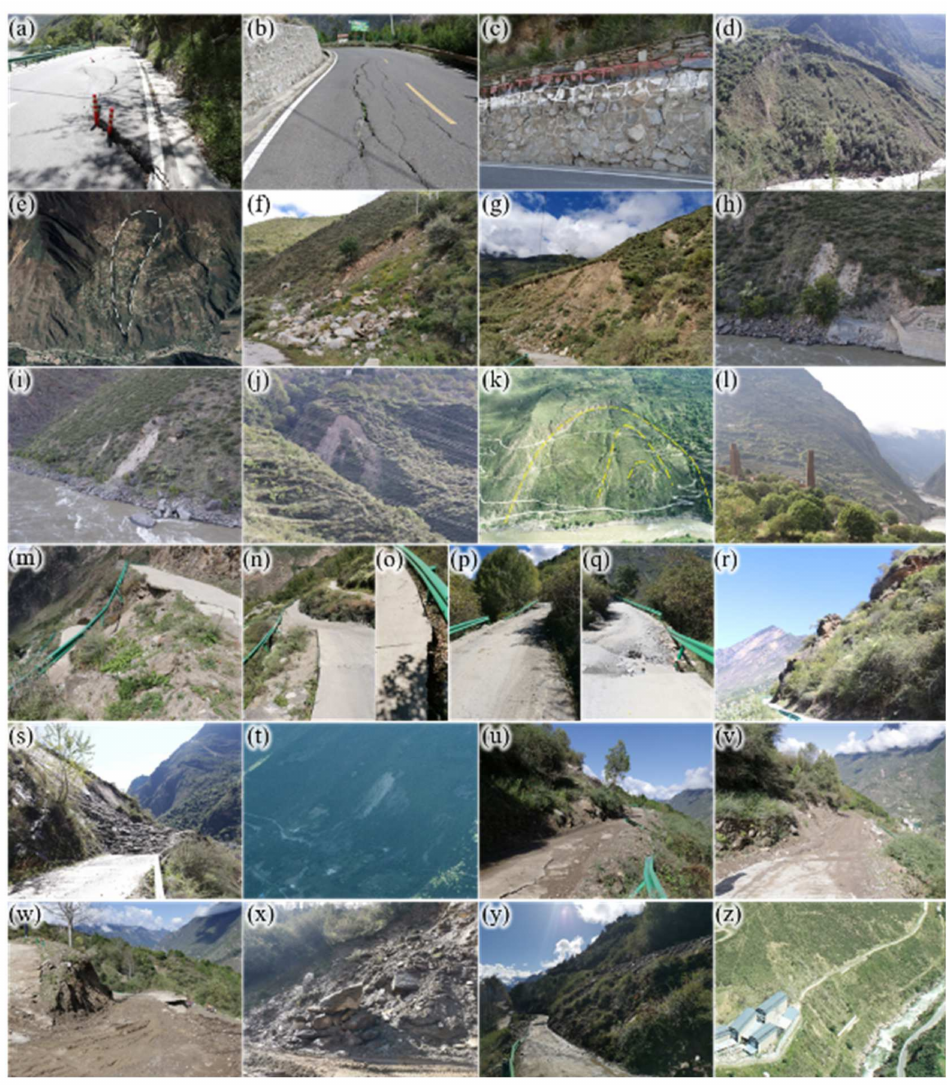
Figure 11. Onsite photos of the real landslides: ( a ) Landslide No. 1; ( b , c ) Landslide No. 2; ( d ) Land- slide No. 5; ( e ) Landslide No. 6; ( f , g ) Landslide No. 7; ( h , i ) Landslide No. 8; ( j ) Landslide No. 9; ( k ) Landslide No. 10; ( l ) Landslide No. 11; ( m ) Landslide No. 12; ( n , o ) Landslide No. 16; ( p – r )